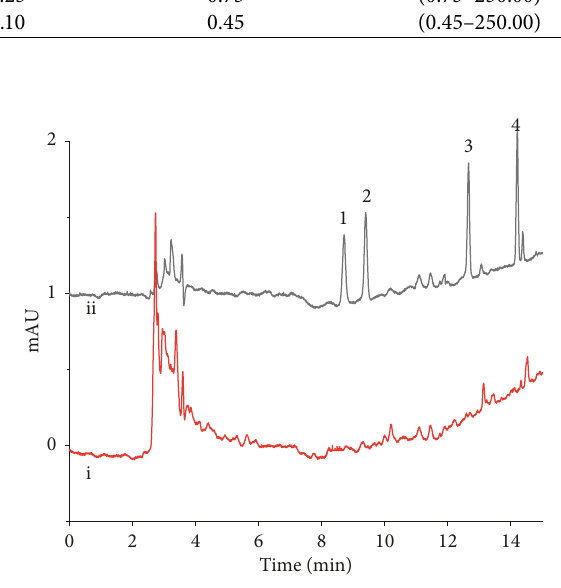
Figure 9: Chromatograms obtained for the water sample by the proposed method. (i) The sample. (ii) The sample spiked with the four SAs, 50.0 μ g.L − 1 . Peak assignments: 1, SM2; 2, SMP; 3, SMZ; 4,